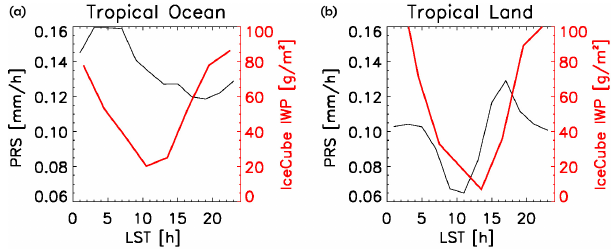
Figure 11. Diurnal cycle for IceCube IWP (red) and surface precip- itation rate (PRS) derived from GPM-DPR radar (black) over trop- ical ocean (a) and land (b) with respect to local solar time (LST). Only IceCube data within a ± 30 ◦ viewing angle are used for gen- erating these statistics, and the tropics are bounded by 20 ◦ S and 20 ◦ N. Time interval is every 3h, and IceCube does not have sam- ples between 22:00 to